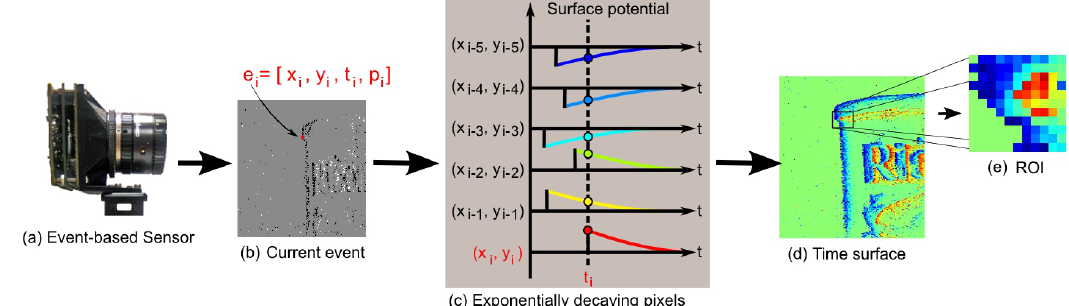
Figure 1. Construction of a spatiotemporal time surface and features from the event-based output of an Asynchronous Time Imaging Sensor (ATIS) camera. The time surface encodes the temporal information from the sensor into a continuous value on the surface in response to the arrival of each event. The ATIS sensor shown in ( a ) generates a stream of events, with an example of a single event shown in ( b ). When an event occurs, such as event e from the pixel ( x i , y i ) at time t i , the value of the surface at that point is changed to reflect the polarity p → {− 1,1 } . An example of the decaying exponentials that generate the time surface at t = t i is shown in ( c ). The exponentially decaying time surface is shown in ( d ). The intensity of the colour on the surface encodes the time elapsed since the arrival of the last event from that pixel. The input to the feature extractor in the Region of Interest (ROI) which consists of a w × w window centered on the event e , as shown in ( e